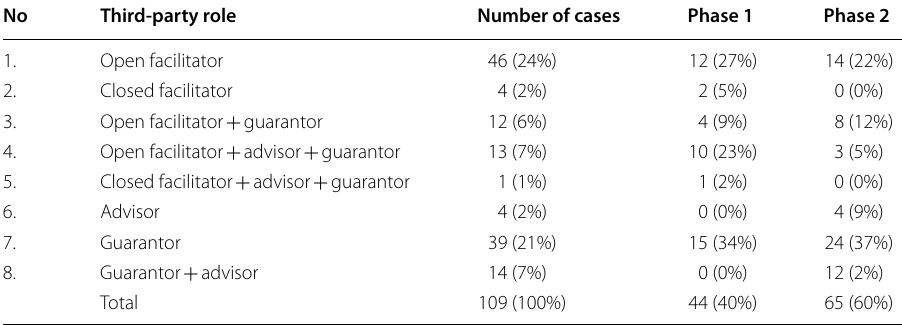
Table 5 Changes in frequencies and proportions of third-party roles at the case level